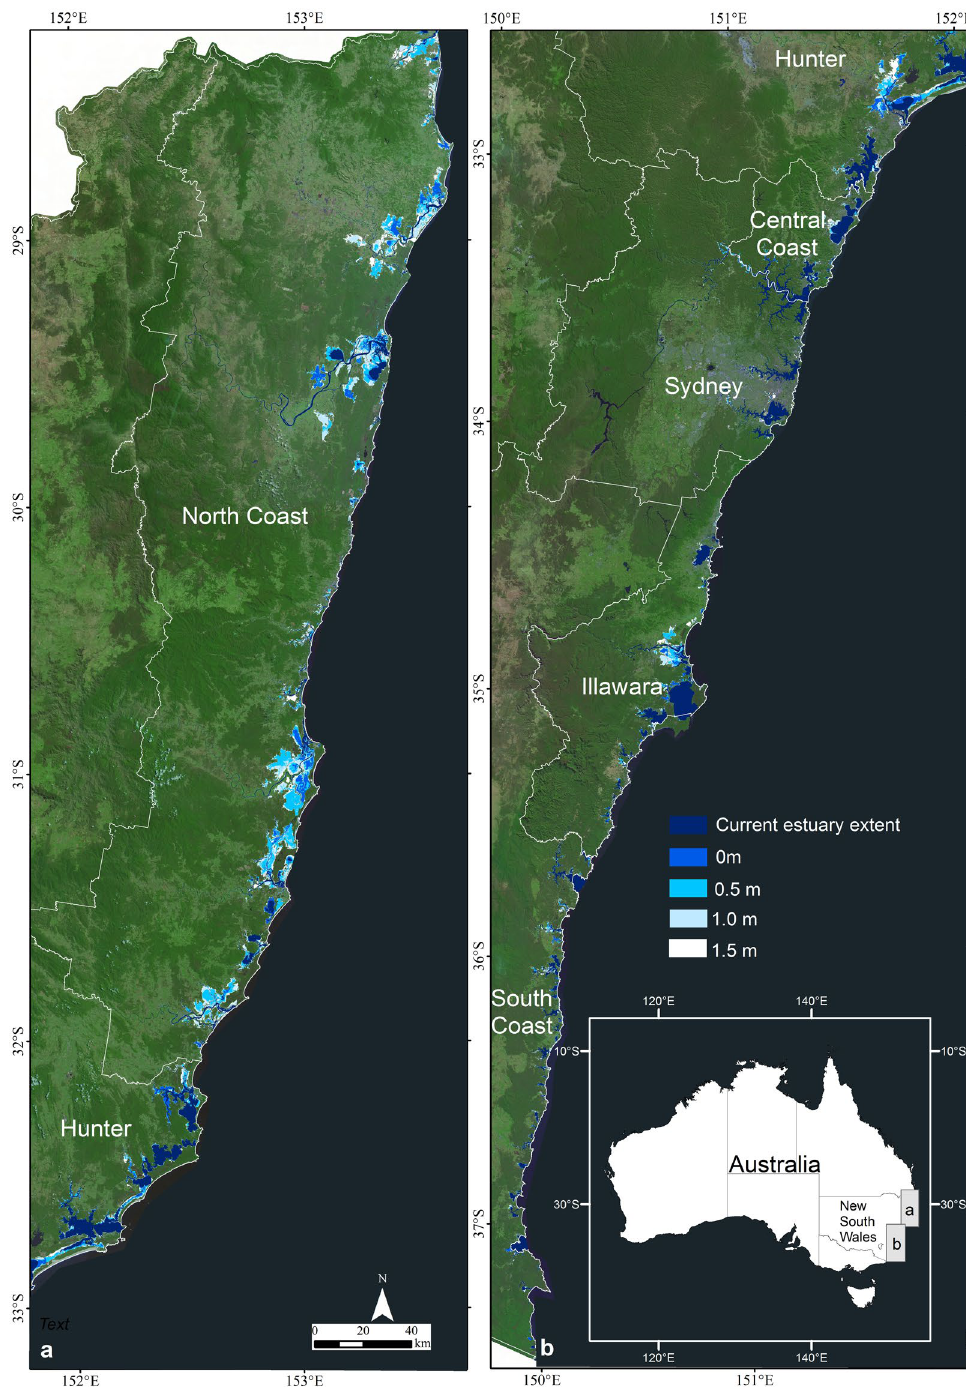
Figure 2. Inundation mapping for the 0 m (current HHWSS or berm level), 0.5 m, 1.0 m and 1.5 m sea level rise scenarios together with the current mapped extent for all 184 estuaries in New South Wales and the regional breakup used in the exposure assessment. This figure was created using ARCGIS v10.4 http://desktop.arcgis.